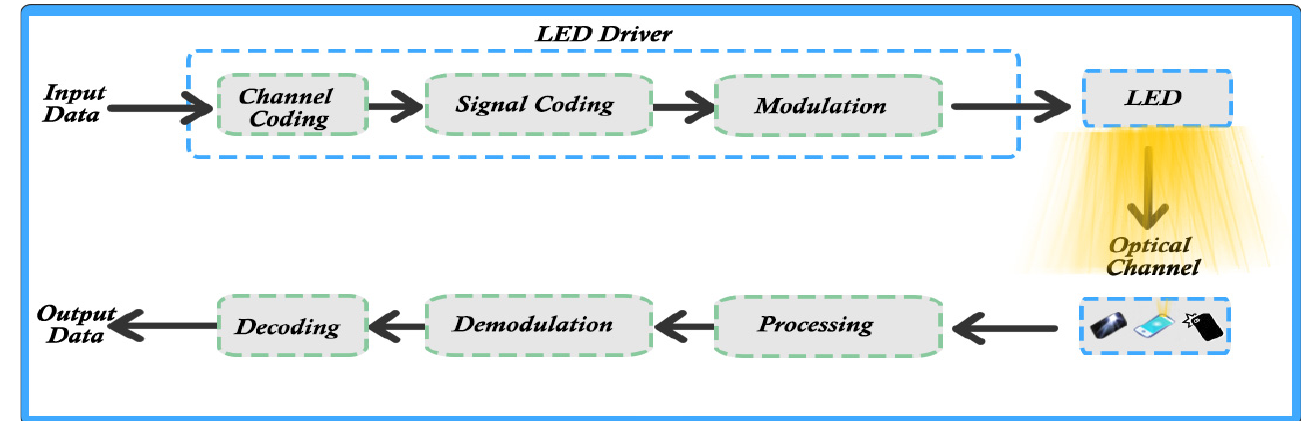
Figure 3. Modulation and demodulation scheme for VLC: mobile communications.